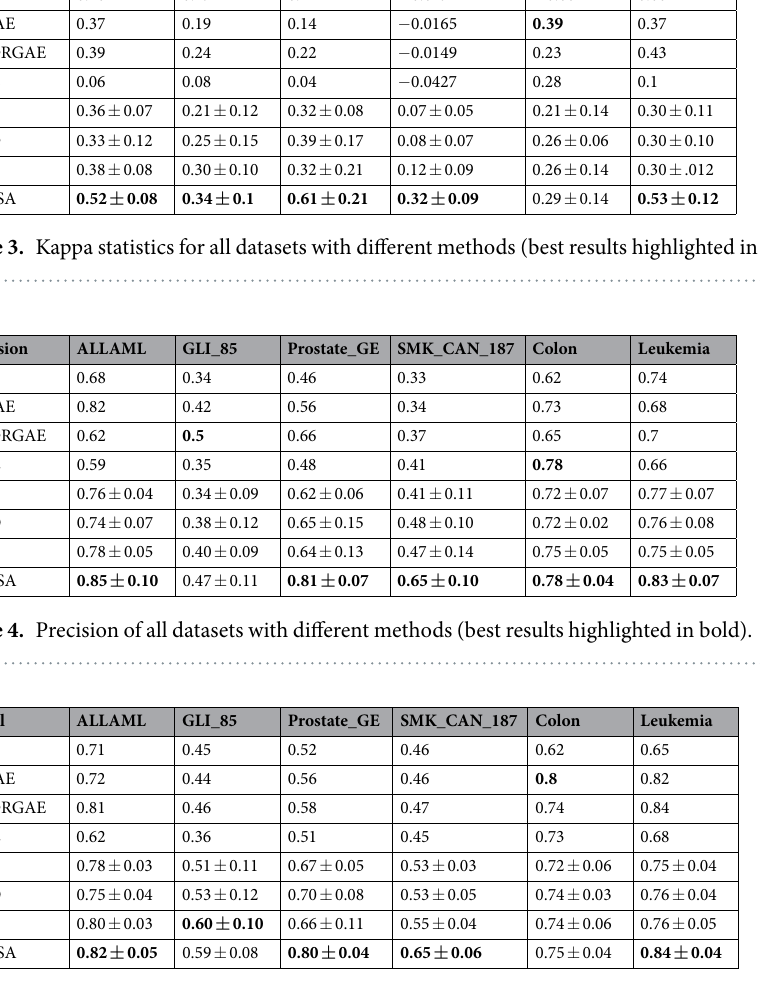
Table 5. Recall of all datasets with different methods (best results highlighted in